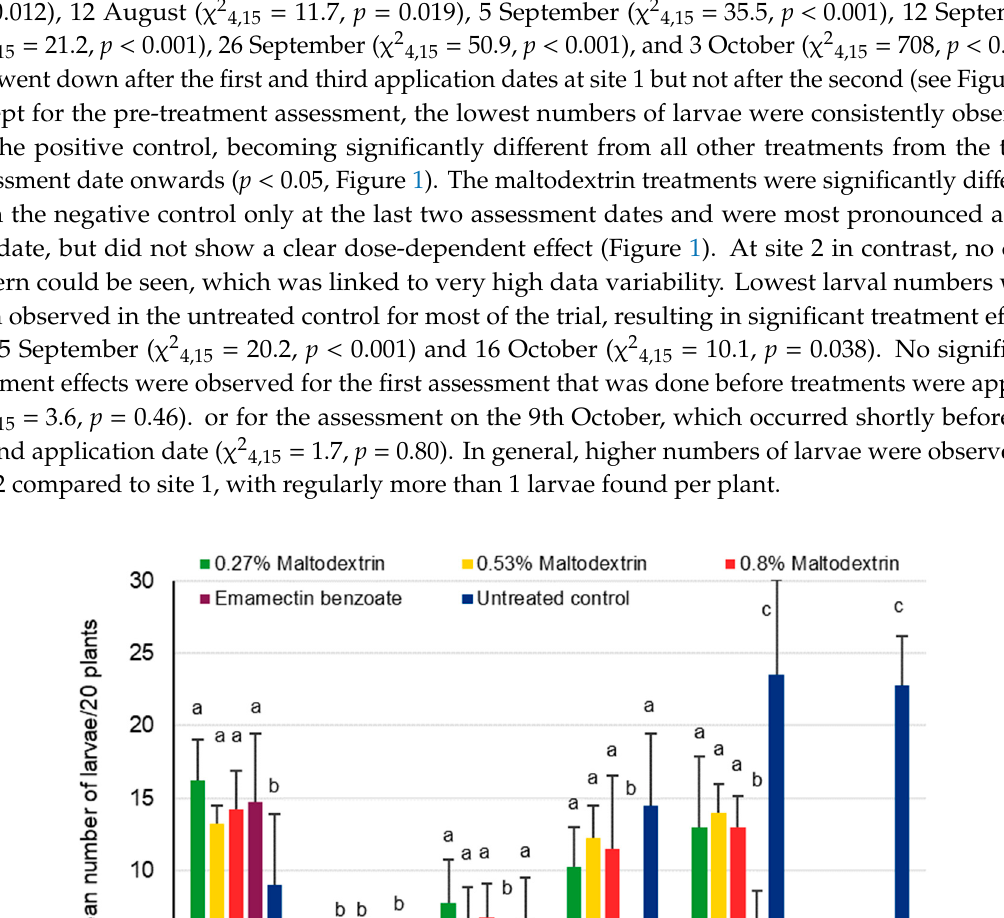
( B ) Figure 1. Mean number of fall armyworm (FAW) larvae + SD found on 20 maize plants in the maltodextrin trial during vegetative growing stages conducted in 2018. Within a given date, bars sharing the same letters are not significantly different from each other. If no letters are shown this indicates that no differences were found. ( A ) Site 1 near Wa, Upper West, Ghana, where treatments were applied on 16 August, 6 September, and 27 September. ( B ) Site 2 near Accra, Ghana, where treatments were applied on 20 September and 10 October. Damage scores were similar at site 1 in the beginning of the experiment at a level of around 2, but increased to a high level of 8.4 (according to Davis scale) for the untreated control towards the end of the vegetative growth period (Figure 2); in the other treatments, scores were between 2 and 4, with the lowest numbers observed in the positive control and slightly higher values for maltodextrin. Significant differences were found for assessments done on 15 August ( χ 24,15 = 36.7, p < 0.001), 5 September ( χ 24,15 = 1518, p < 0.001), 12 September ( χ 24,15 = 307, p < 0.001), and 3 October ( χ 24,15 = 266, p < 0.001) (Figure 2). At site 2, crop damage was zero during the first assessment on 19th September, quickly rising to levels of 4 or more for all treatments except the untreated control. Significant